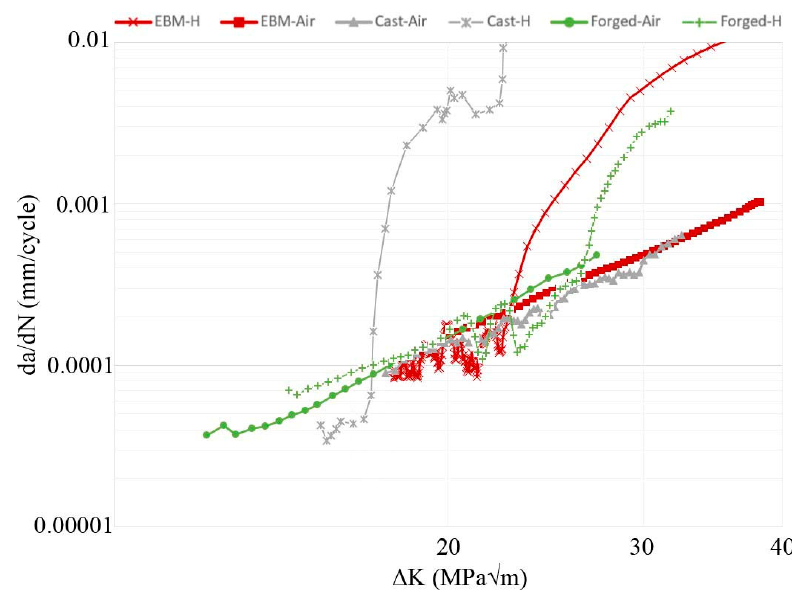
Figure 13. Fatigue crack growth (FCG) data for EBM, forged [26], and cast [28] Ti-6Al-4V. The FCG properties of material exposed to air and hydrogen atmosphere are shown, where the crack growth rate da/dN is plotted on the y-axis and the Δ K on the x-axis.